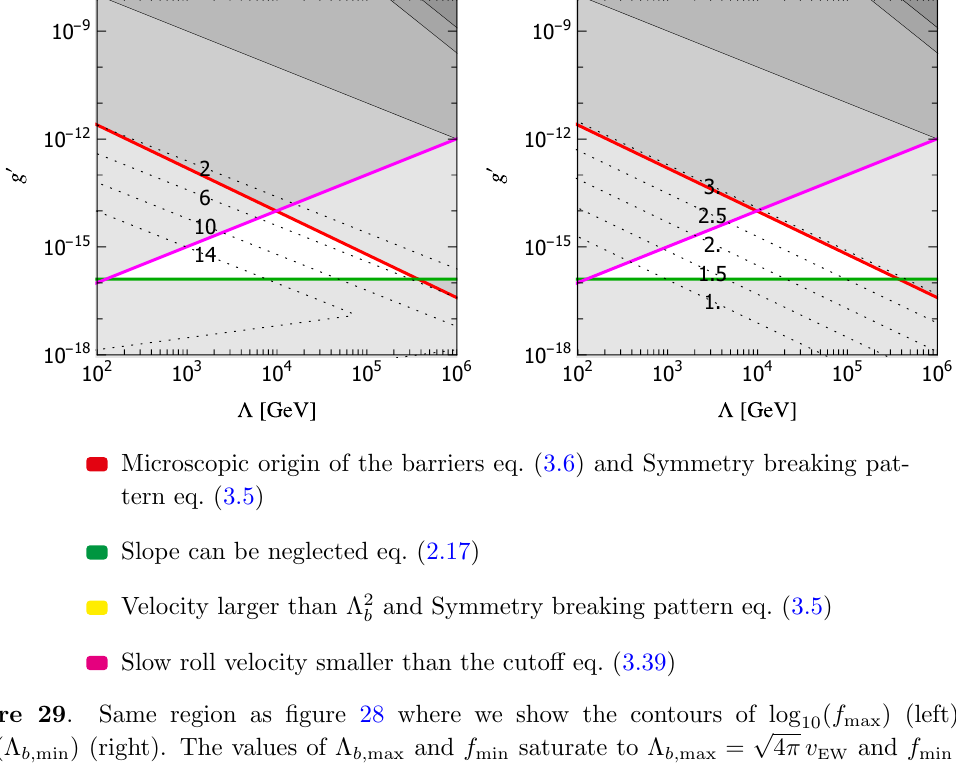
Figure 29 . Same region as (cid:12)gure 28 where we show the contours of log log ((cid:3) b; min ) (right). The values of (cid:3) b; max and f min saturate to (cid:3) b; max = p 4 (cid:25) v 10